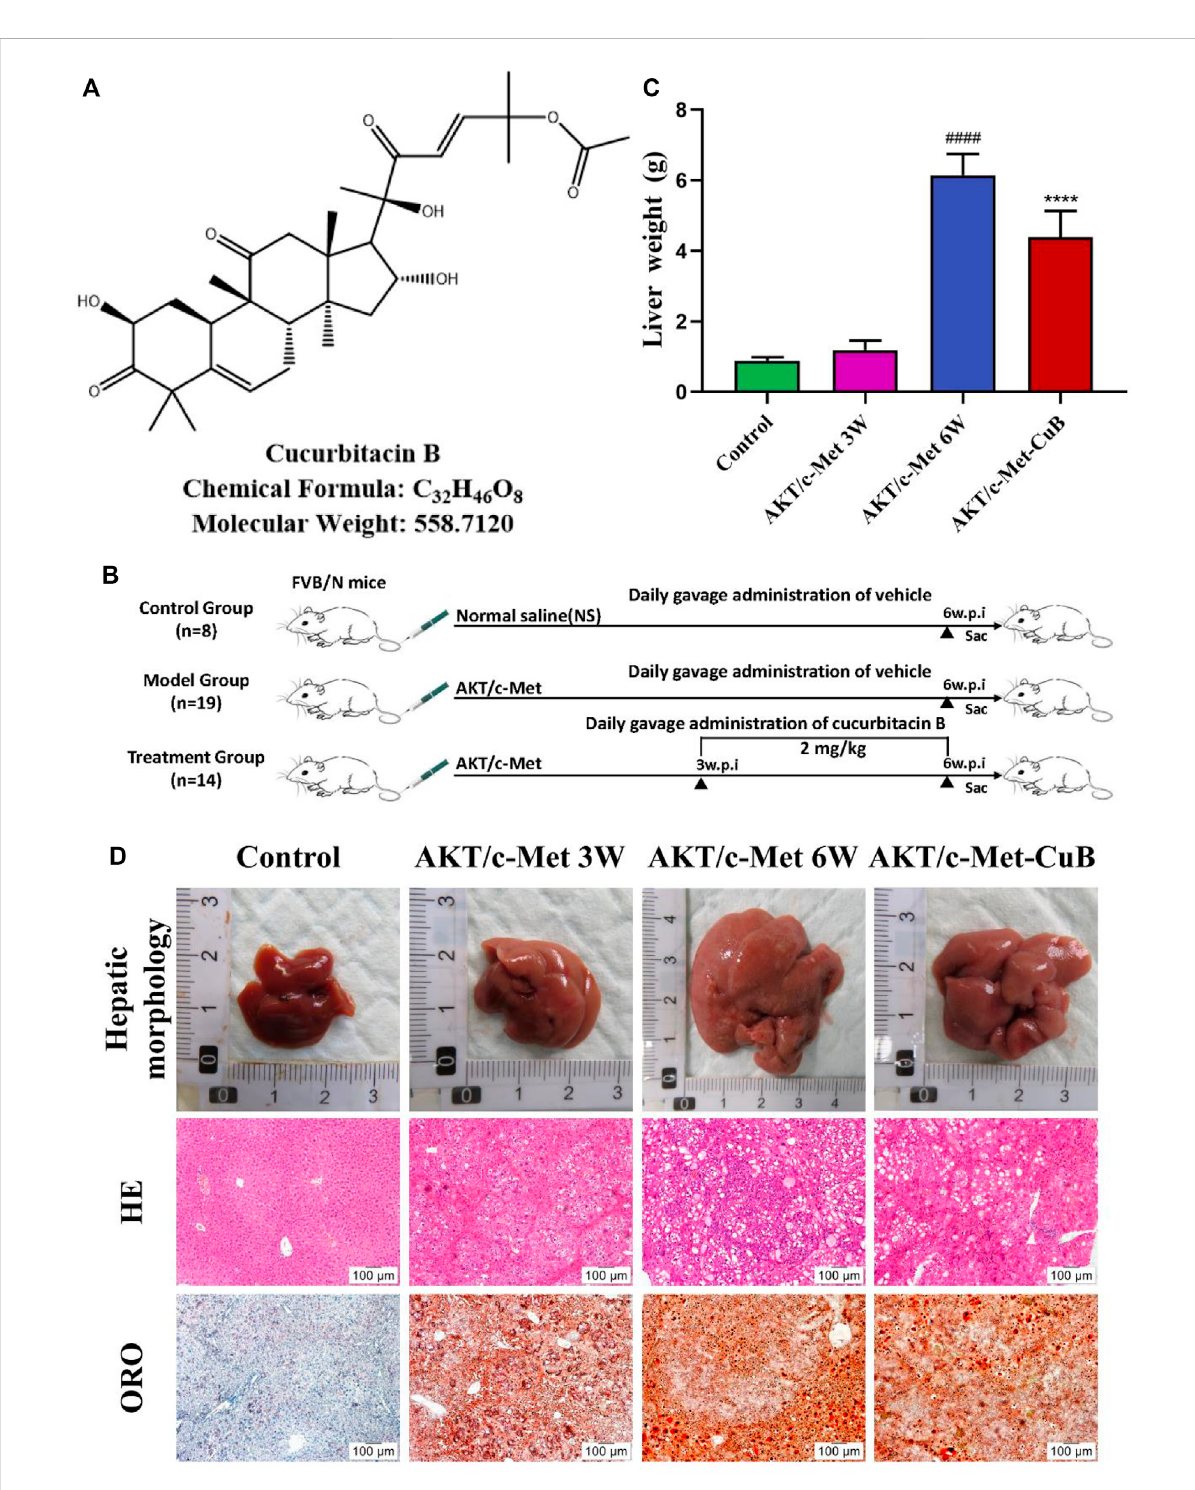
FIGURE 1 Co-expression AKT/c-Met-triggered rapid hepatocarcinogenesis and the inhibitory effect of CuB in mice. (A) CuB structure, chemical formula, and molecular weight; (B) Design of research process; (C) Liver weight of mice in each group (Mean ± S.D., n = 3. #### p < 0.0001 vs. Control group; **** p < 0.0001 vs. AKT/c-Met group, pounds and asterisks indicate statistical signi fi cance as determined by two-tailed unpaired t -test comparisons with two groups); (D) Hepatic morphology, HE, and ORO results of mice in each group (Magni fi cation: ×100. w.p.i., weeks